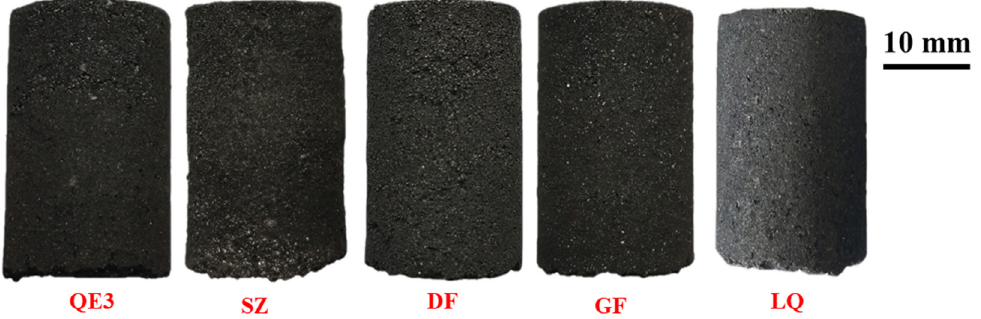
Figure 10. Macroscopic morphology of ferro-coke with different binders.